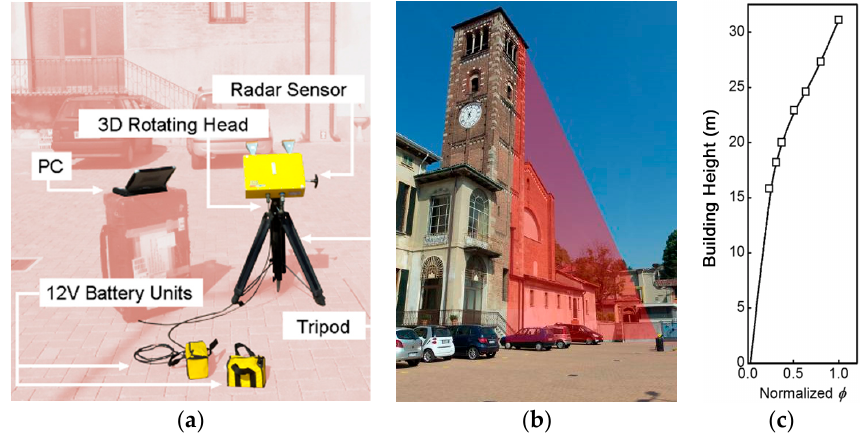
Figure 8. Carrobiolo Bell Tower in Monza: ( a ) Microwave interferometer (IDS, model IBIS-S); ( b ) Radar position in the dynamic test of the tower; ( c ) Mode shape ( Φ ) associated to the fundament frequency ( f = 1.93 Hz, ambient excitation) [20].